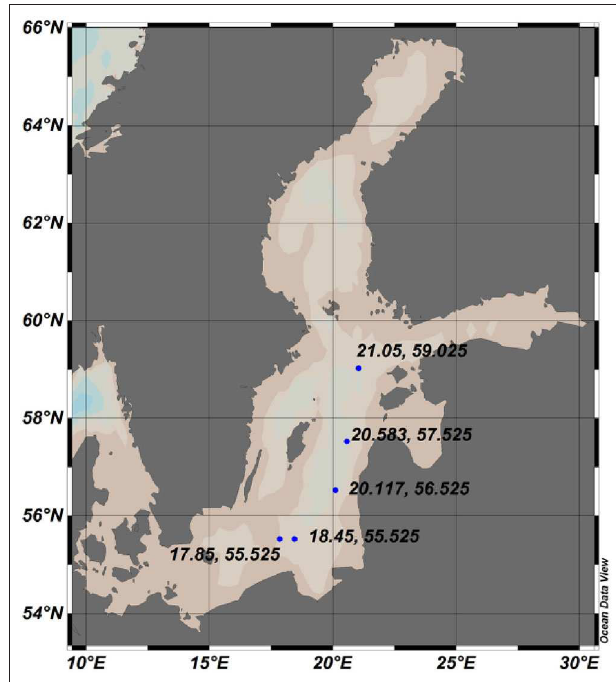
FIGURE 1 | Locations of data points from the World Ocean Database used for comparison with the output ot the RCO